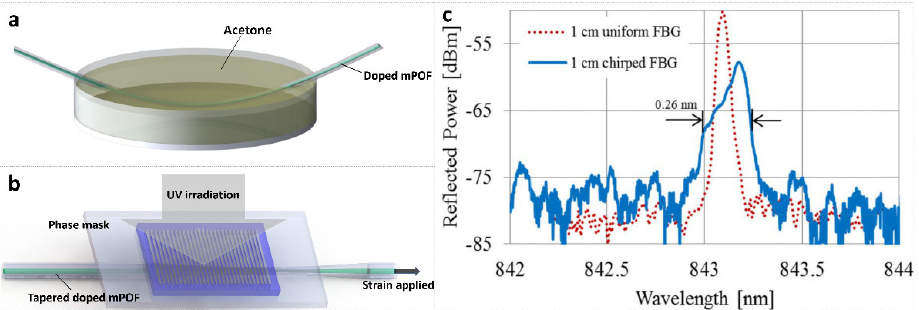
Figure 17. ( a ) Sketch of tapered mPOF fabrication. ( b ) CFBG inscription set ‐ up with tapered mPOF and a uniform phase mask. ( c ) Reflected amplitude spectra of CFBG and uniform FBG. Reprinted from [93].